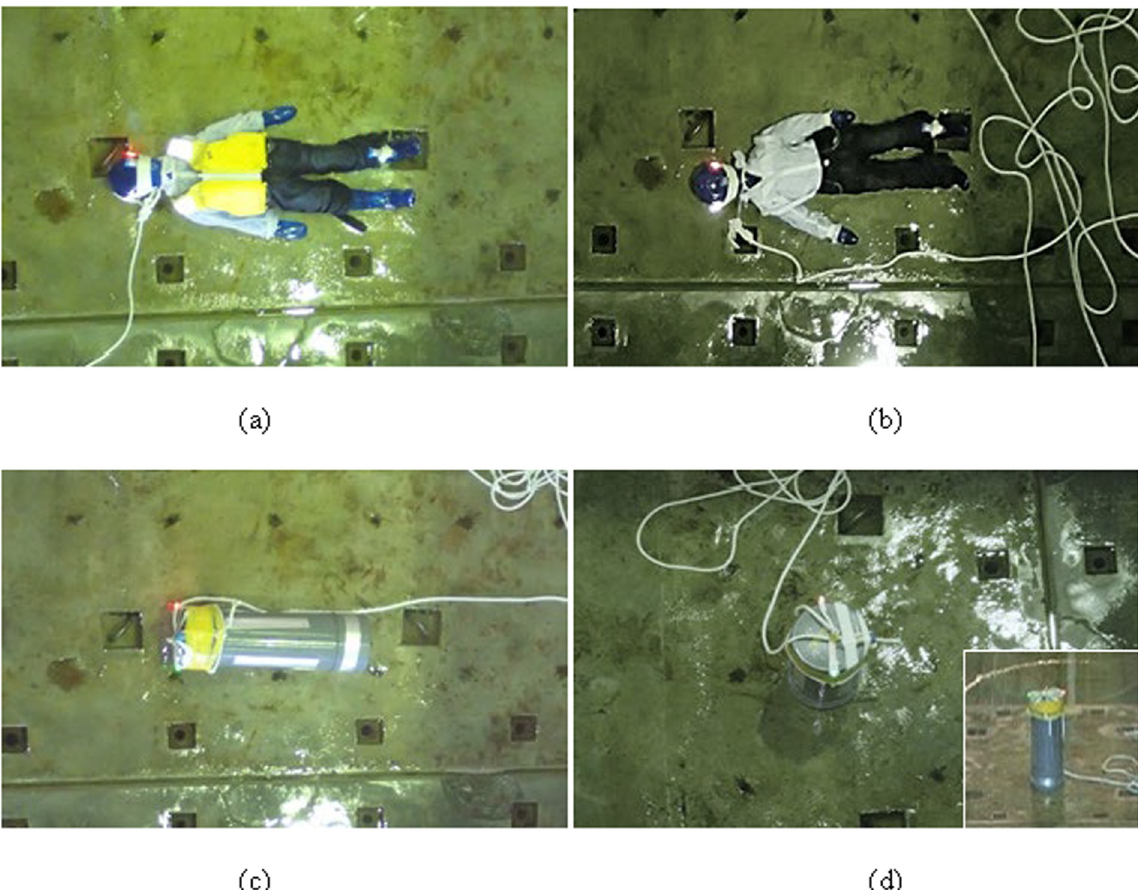
Fig 2. Test bodies used in the experiment (photos taken from a camera placed overhead): 3D kids model (KM) (a) with and (b) without PFD; PVC pipe in (c) lying position and (d) standing position (lower right shows the side view). The figures show the initial condition for each test body before being struck by a tsunami